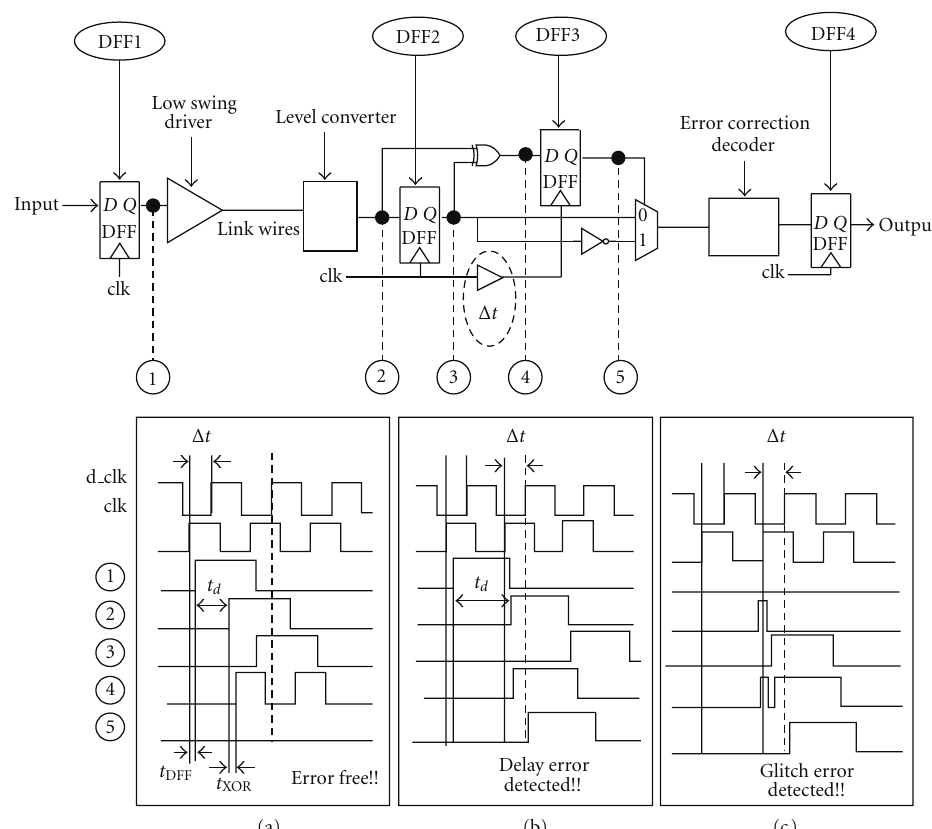
Figure 14: Modified double sampling data checking circuit and waveforms. (a) Error-free. (b) Delay error. (c) Glitch error.